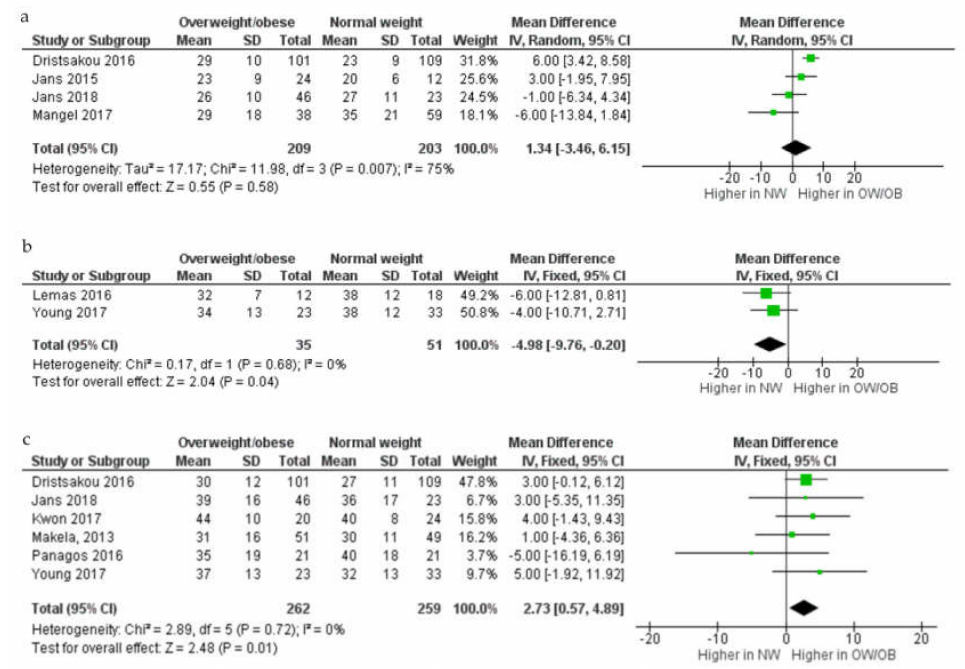
Figure 2. Comparison of fat concentration (g / L) from normal weight and overweight and obese women according to stage of lactation, colostrum ( a ), transitional ( b ) and mature ( c ). CI, confidence interval; Chi 2 and I 2 , measures of heterogeneity; IV, inverse variance; NW, normal weight women; OB, obese women; OW, overweight women; SD, standard